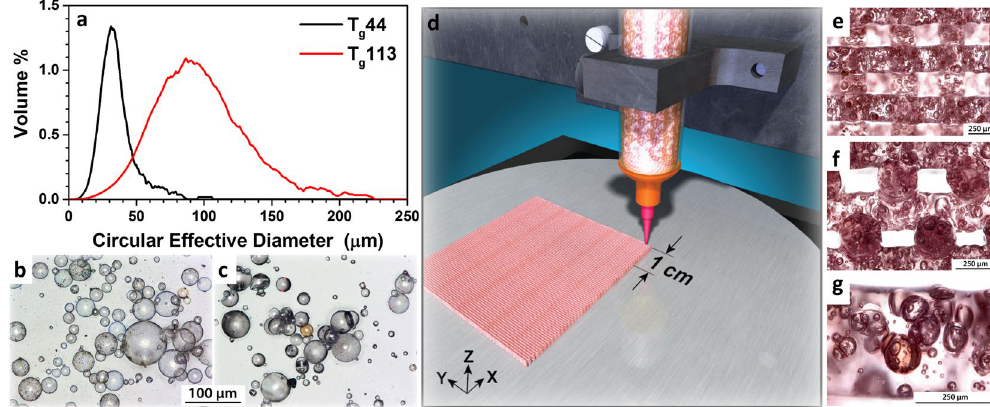
Figure 1. ( a ) Microballoon diameter size distribution, optical microscopy images of ( b ) T g 44 and ( c ) T g 113 microballoons, ( d ) schematic illustration of our 3D printing process, optical microscopy images of printed silicones with microballoons showing ( e ) x-y view, ( f ) x-z view and ( g ) high magnification image of ( f ) showing 25 vol% microballoons in a printed